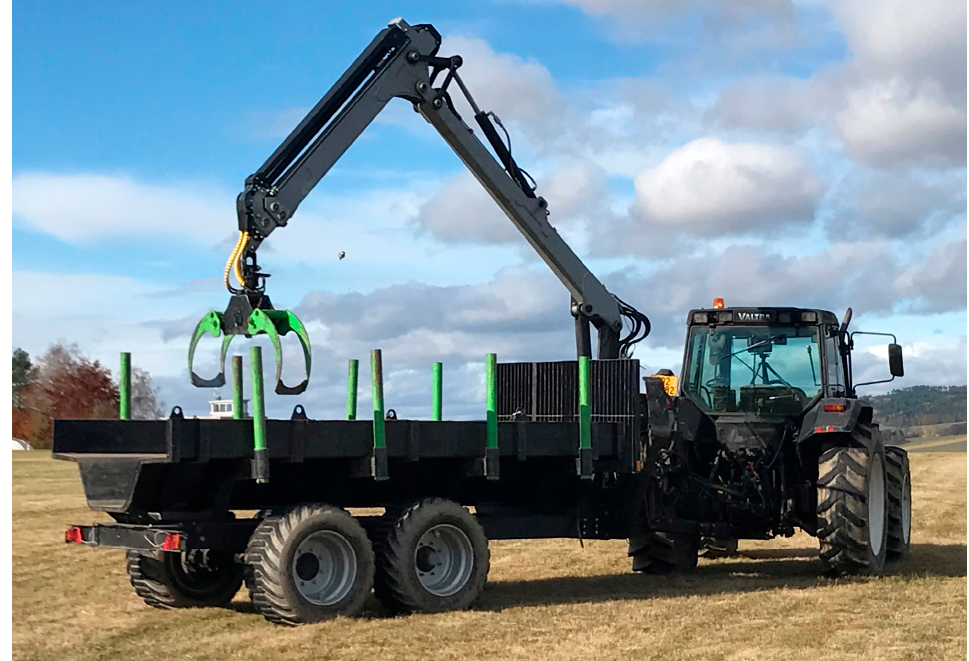
Figure 1. Timber tractor and trailer unit Valtra T 6300 with coupling trailer STS 12T.